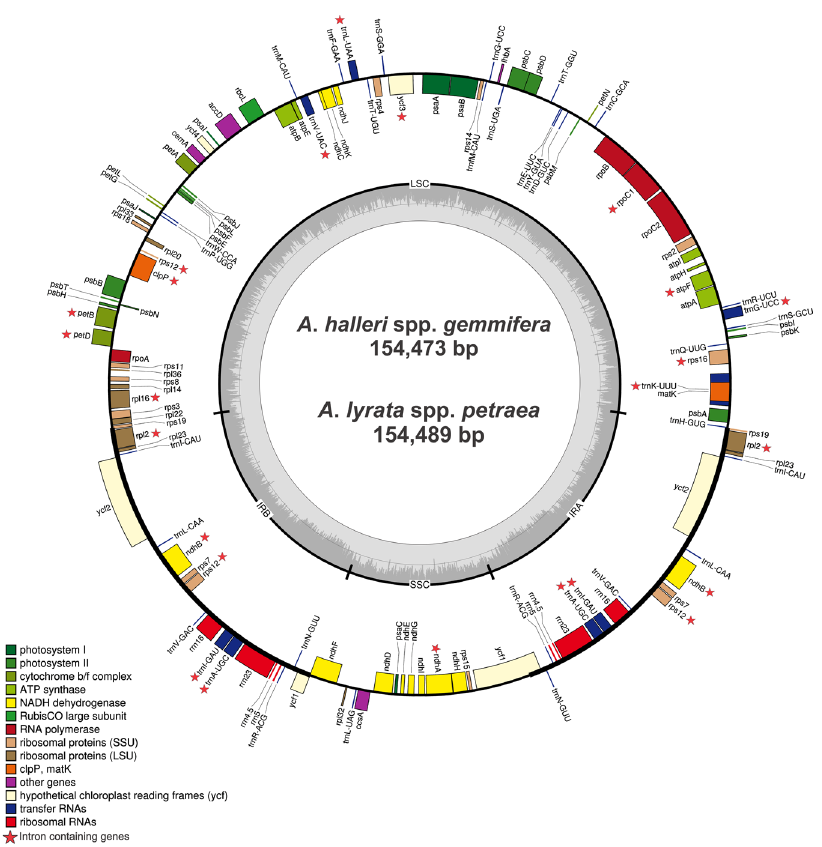
Figure 1. Gene map of the A . halleri ssp. gemmifera and A . lyrata ssp. petraea chloroplast genomes. Genes drawn inside the circle are transcribed clockwise, and those outside the circle are transcribed counter clockwise. The asterisks indicate intron-containing genes. Genes belonging to different functional groups are colour- coded. The darker grey in the inner circle corresponds to GC content, and the lighter grey corresponds to AT